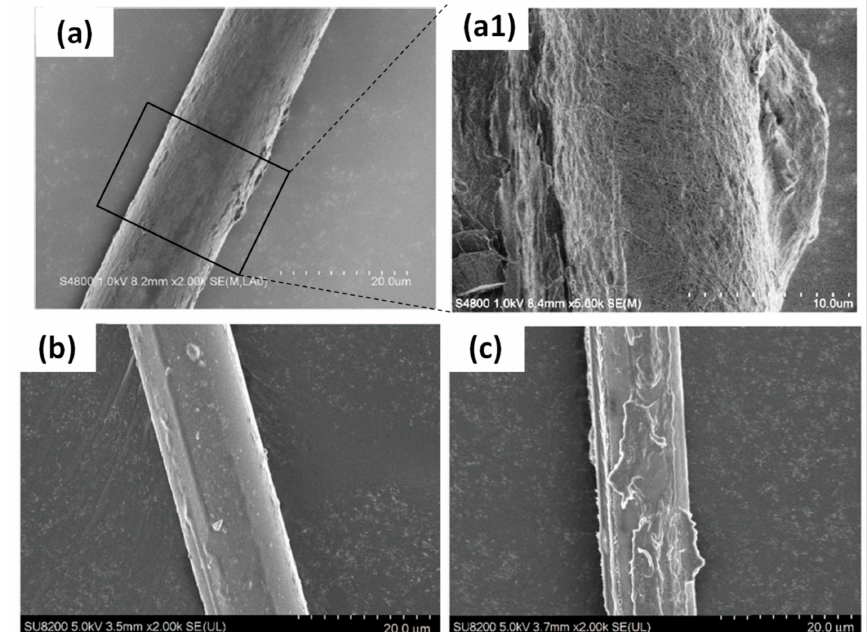
Figure 14. SEM images of hierarchical glass fibres ( a ) and ( a1 ) BC grown on glass fibres, ( b , c ) CNC coated glass fibres with respectively 1 wt% and 5 wt% CNC content in suspensions (reprinted with permission from Chen et al., 2014 [79] and Asadi et al., 2016